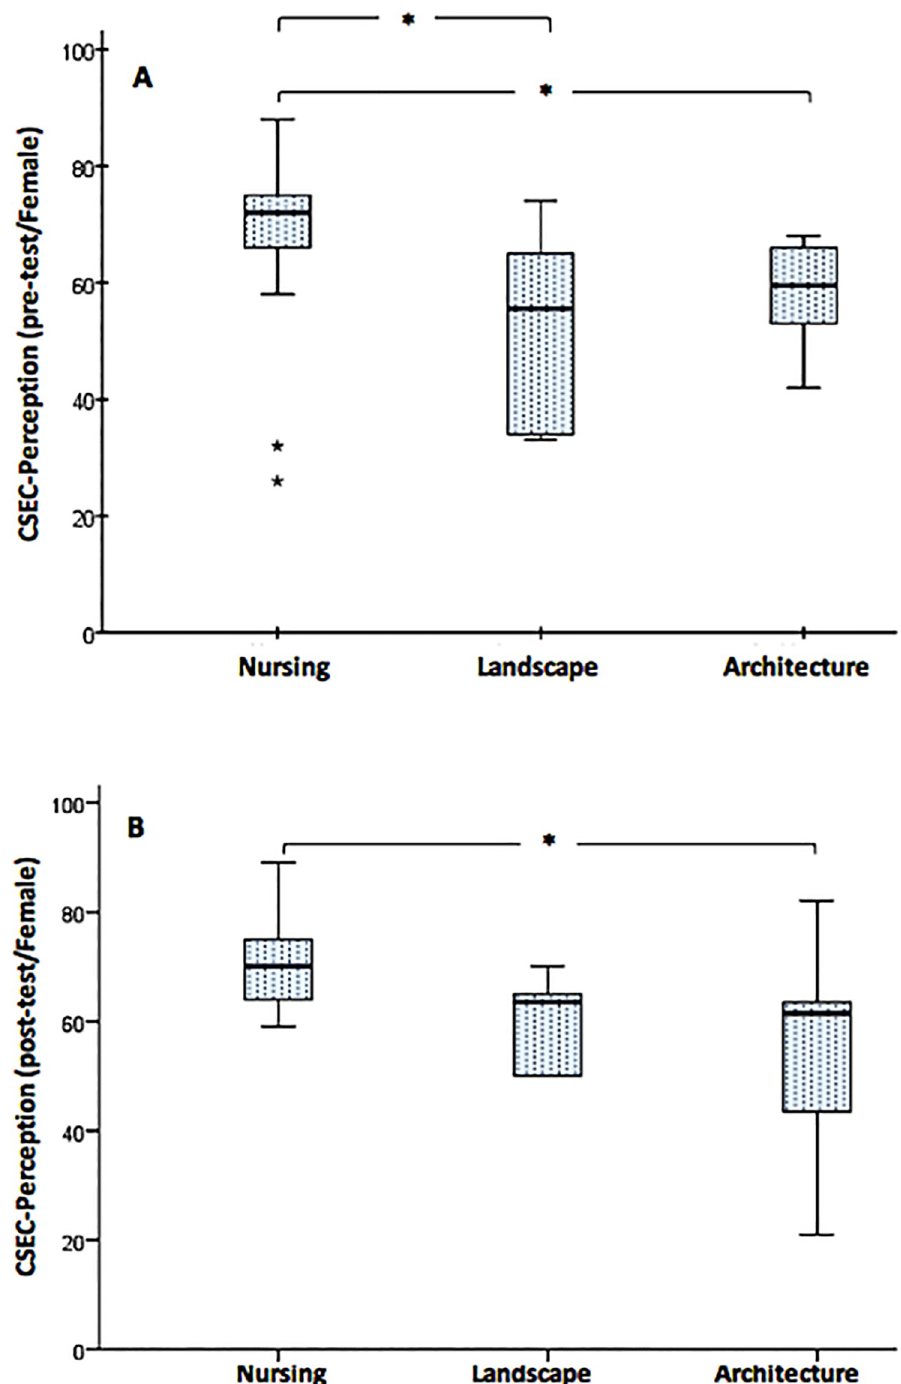
Fig 3. A-B. Comparison of CSES-Perception median scores across the three study groups in both measurement sessions (pre-test and post-test) in the female group. The boxplots demonstrate comparison of CSES-Perception median scores across the three study groups in the pre-test, 3A (Nursing = 72, Landscape = 56, Architecture = 60) and the post-test, 3B (Nursing = 70, Landscape = 64, Architecture = 62). The boxes are bound by the interquartile range (IQR) (top of the box represents the 75th percentile, while the bottom of the box represents the 25th percentile). The boxes are divided by the median, and the whiskers attached to the box represent the minimum and maximum scores. Pairwise comparison demonstrated statistically significant differences in the CSES Empathy scores across different study groups (Kruskal-Wallis Rank Sum test, � p < 0.05; 2-tailed).